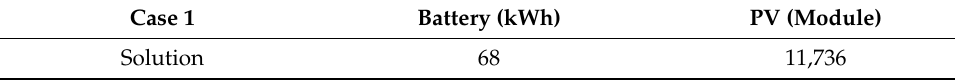
Table 2. Solution of Case